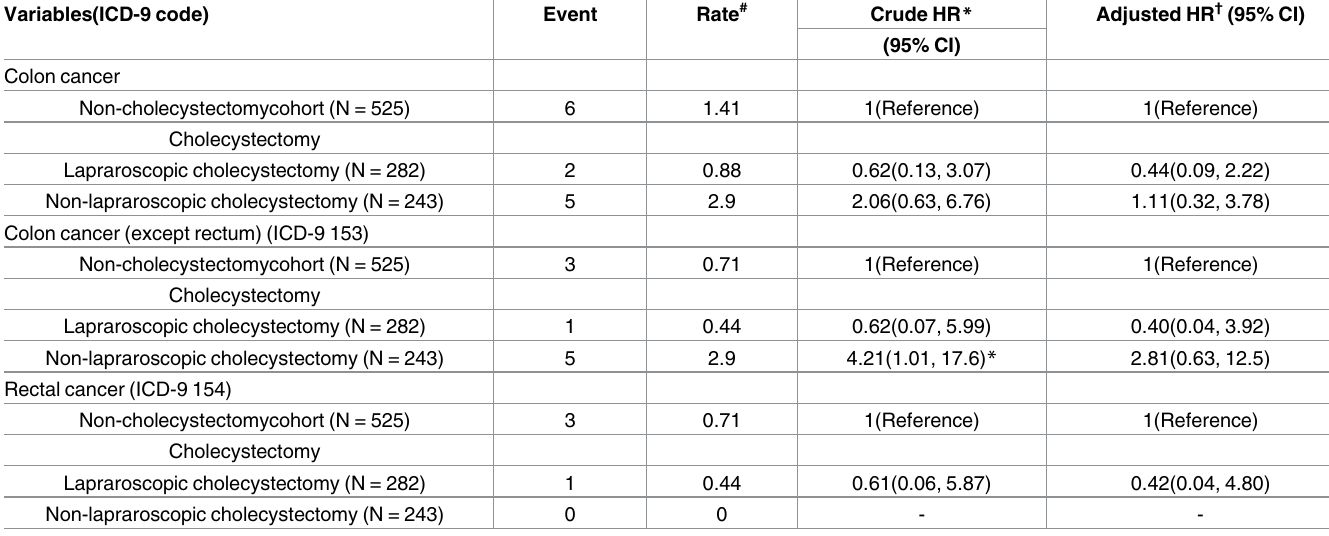
Table 4. Incidence of colorectal cancer location using Cox model measuredhazards ratio by type of cholecystectomy. Variables(ICD-9